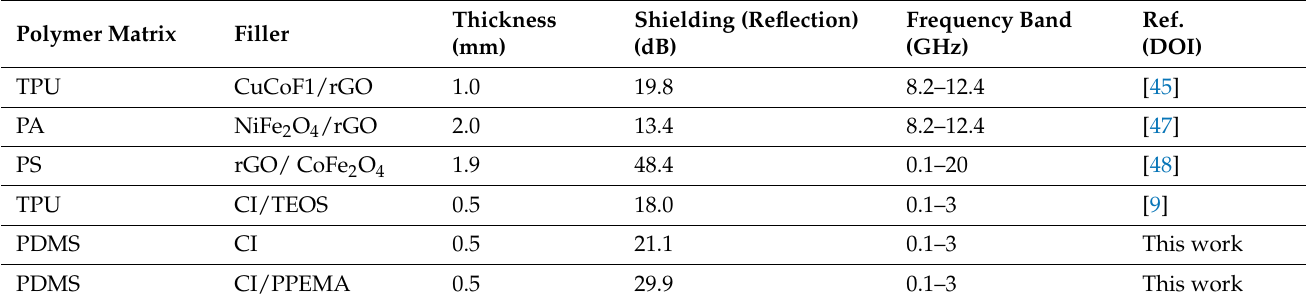
Table 1. previous